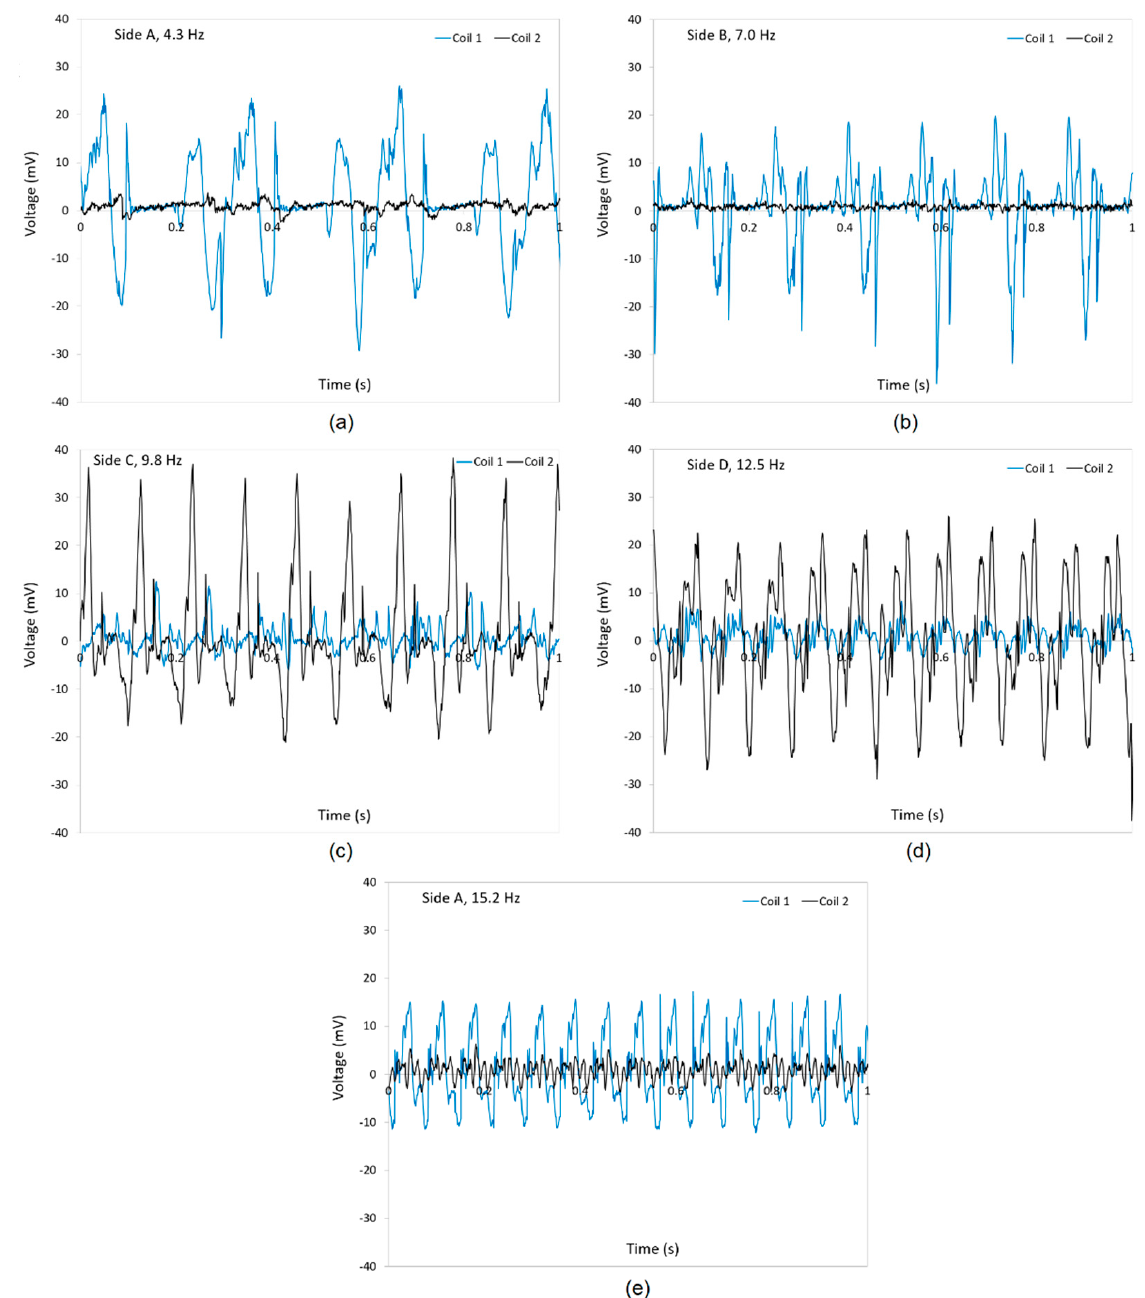
Figure 6. Generated voltages in coils 1 and 2 of the energy harvester as a function of time when ( a ) side A is subject to a compression at 4.3 Hz rate, ( b ) side B is subjected to a compression at 7.0 Hz rate, ( c ) side C is subjected to a compression at 9.8 Hz rate, ( d ) side D is subjected to a compression at 12.5 Hz rate, and ( e ) side A is subjected to a compression at 15.2 Hz